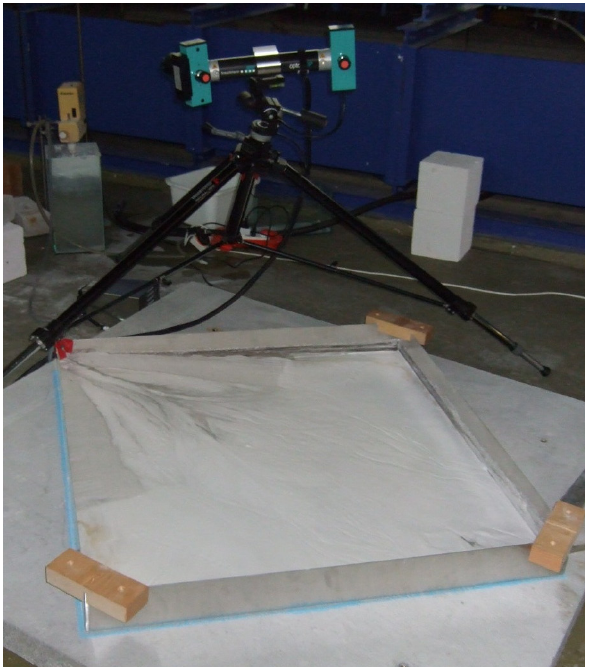
Figure 2. Breuckmann optoTOP-SE scanner.